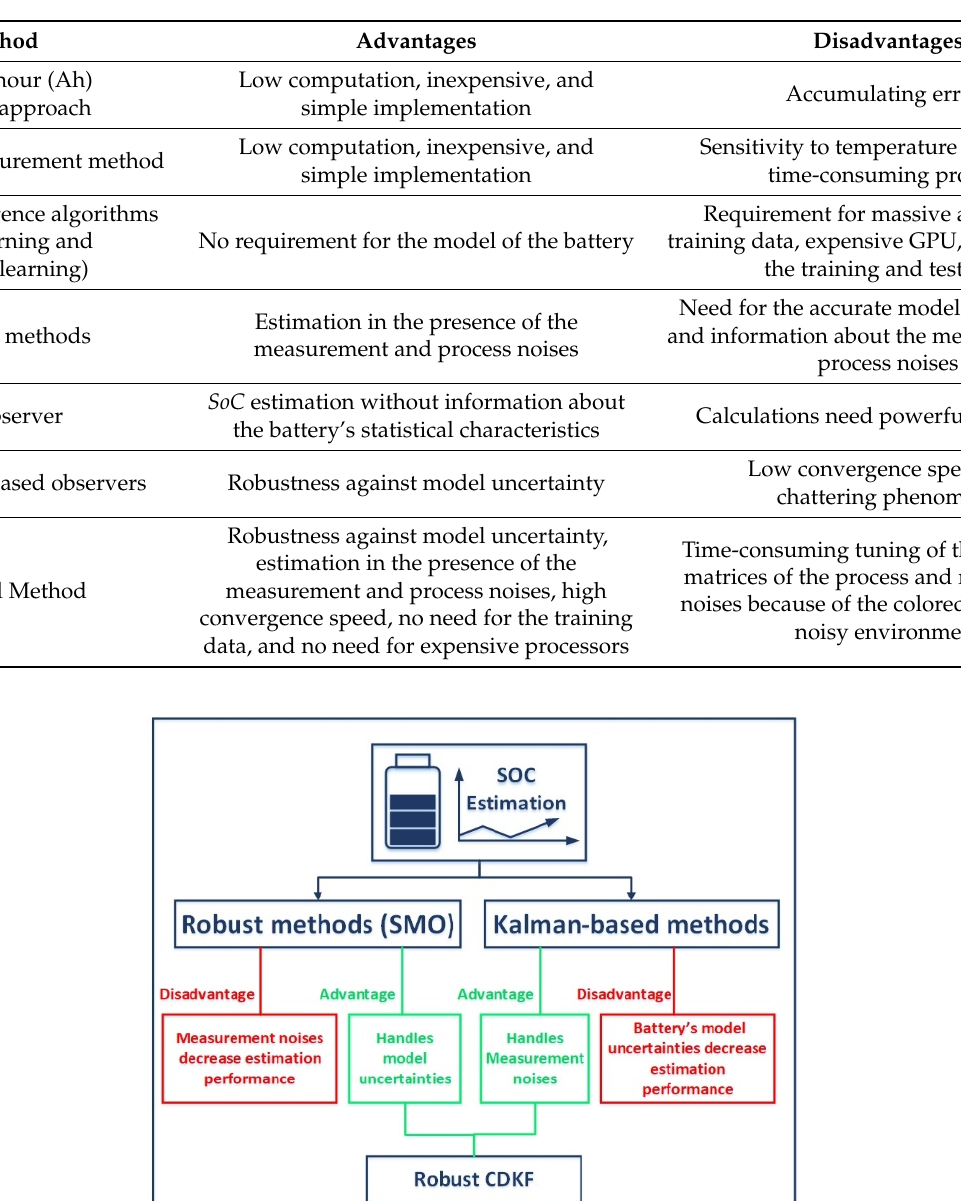
Table 1. A comparison among different SoC estimation methods.